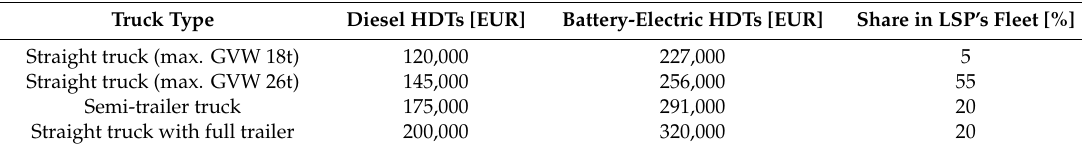
Table 1. Net list price for heavy-duty trucks (HDTs) in 2018 and share in the logistics service provider’s (LSP) Figure 2. Basic model structure.